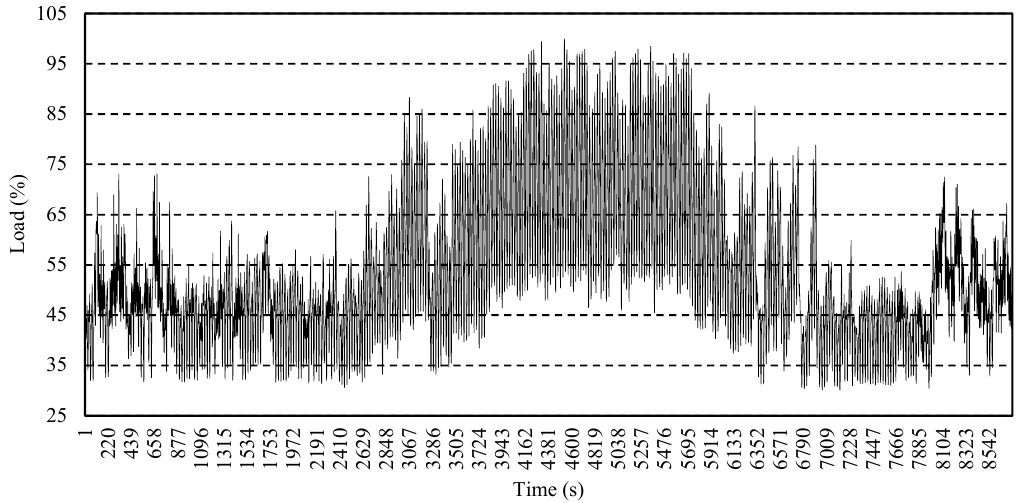
Figure 5. Wind speed for one year.